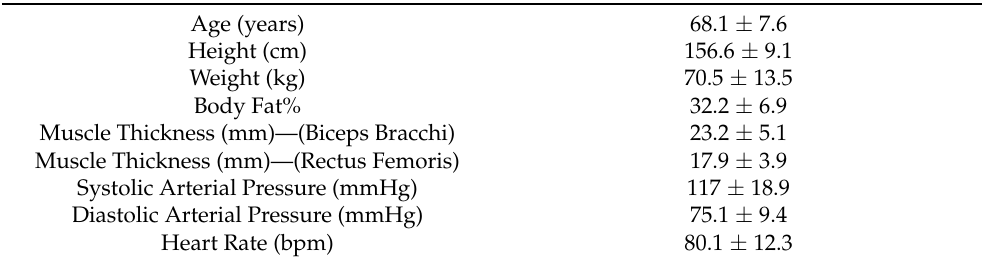
Table 1. Characteristics of subjects ( n =